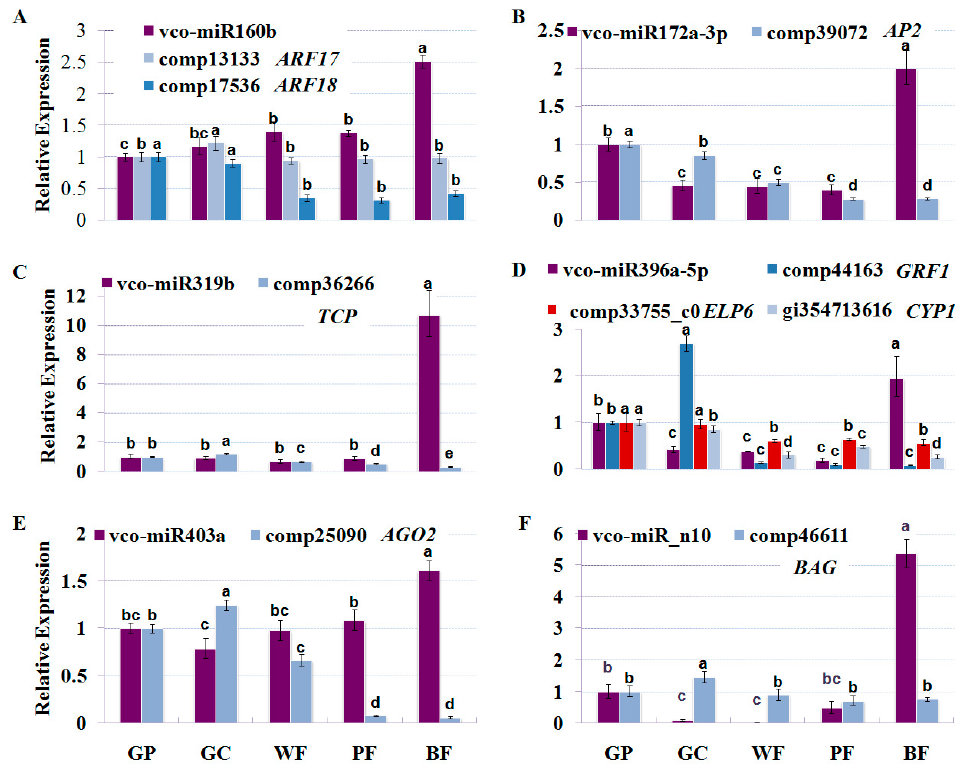
Figure 7. Expression patterns of the known and novel vco-miRNAs identified in this work and their target genes during fruit development and ripening. The accumulation patterns of vco-miR160b and 2 target genes ( A ), vco-miR172a-3p and its target gene ( B ); vco-miR319b and its target gene ( C ); vco-miR396a-5p and 3 target genes ( D ); vco-miR403a and its target gene ( E ); vco-miR_n10 and its target gene ( F ). The expression level in GP was set as 1. U6 and ACTIN genes were used as the internal control for miRNA expression and target genes expression, respectively. Error bars indicate standard error of three biological and technical replicates. The different letters (a–d) indicate significant differences at p < 0.01 according to Duncan’s multiple range tests. GP, green pad; GC, green cup; WF, white fruit; PF, pink fruit; BF, blue fruit.